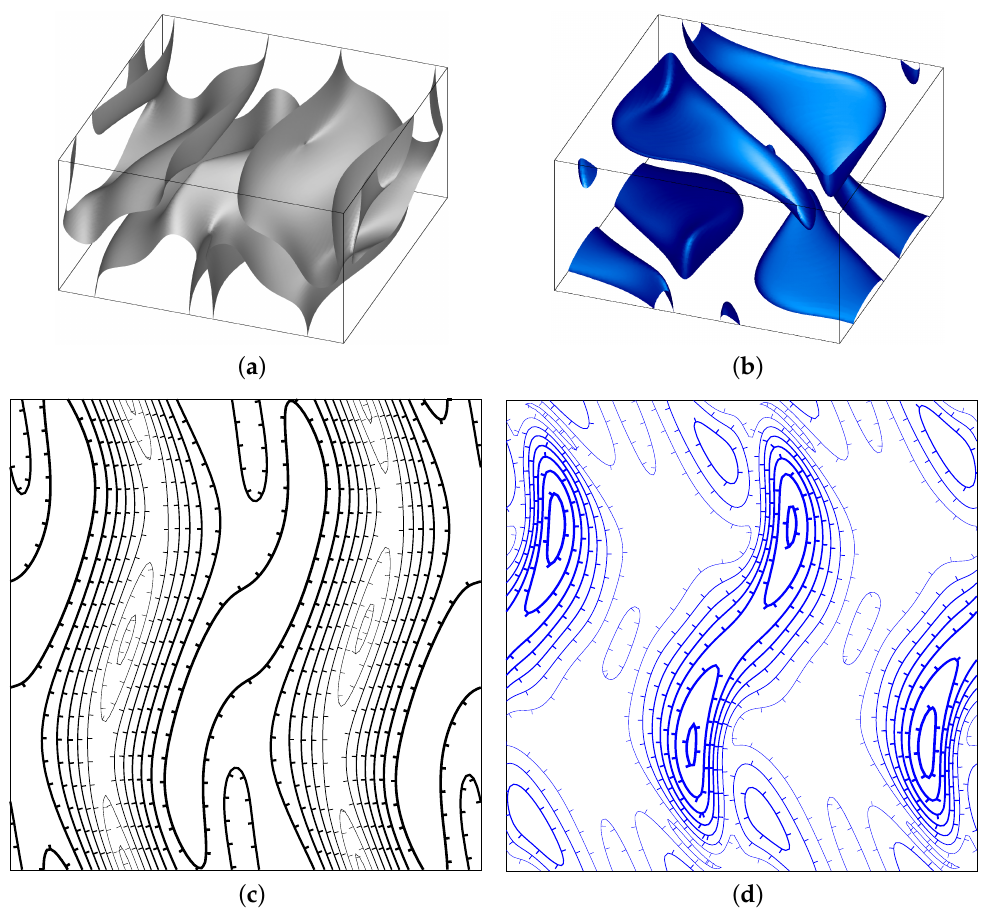
Figure 1. Isosurfaces of the kinetic (a) and magnetic (b) energy densities at the levels of 1/2 of the respective maxima of the unperturbed short-scale convective dynamo steady state. One periodicity box is shown. Isolines of the kinetic (c) and magnetic (d) energy densities on the midplane x 3 = 0, step 1.5 and 0.3, respectively. In (c) and (d), the line width increases with the common along-the-line value of the energy